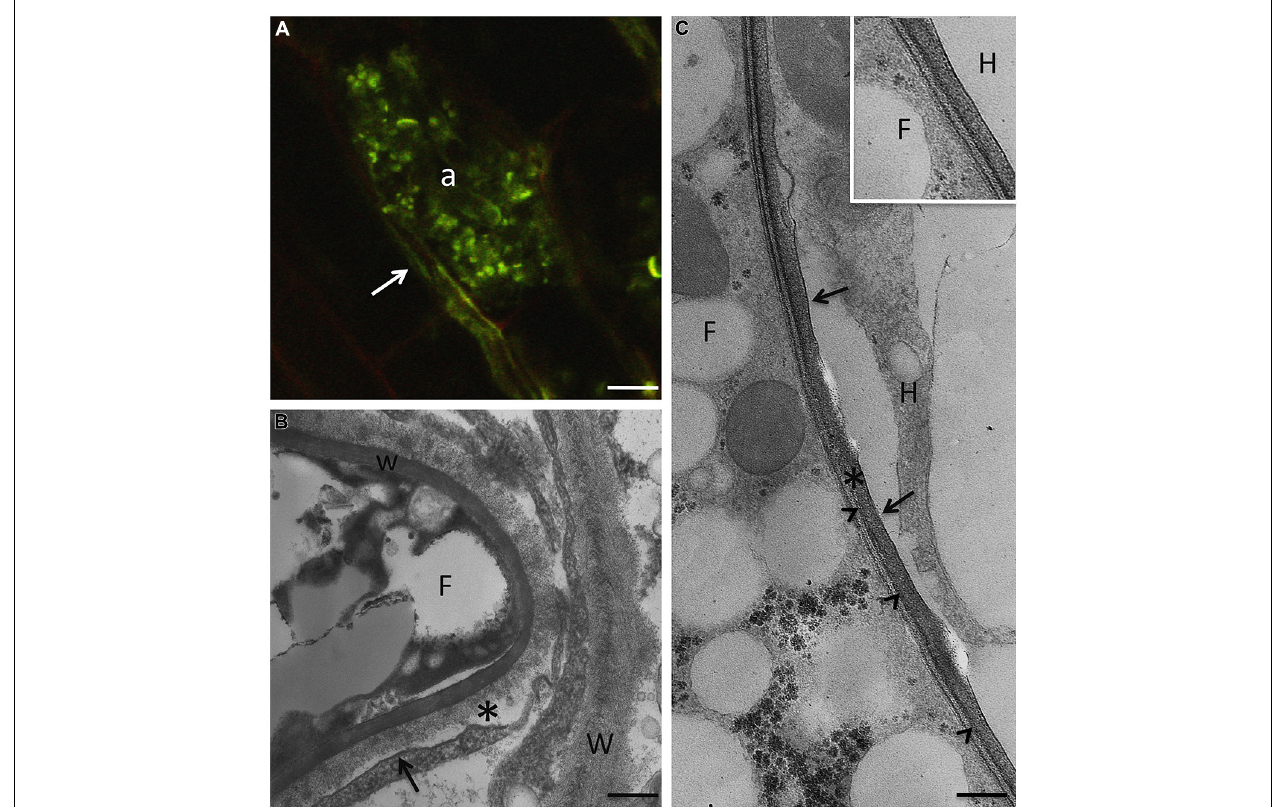
FIGURE 1 | In AM symbiosis, once the fungus overcomes the epidermal layer, it grows inter- and intracellularly all along the root in order to spread fungal structures. Only when the fungus reaches the cortical layers, does a peculiar branching process that leads to the highly branched structures, called arbuscules, which are the main site for nutrient exchanges. (A) R. irregularis arbuscule (a) after staining with wheat germ agglutinin-FITC, on paraffin section of M. truncatula root, to detect chitin in the fungal cell wall. Arrow points to an intercellular hypha. Bar, 7 μ m. (B) At the electron microscope level, a new apoplastic space, based on